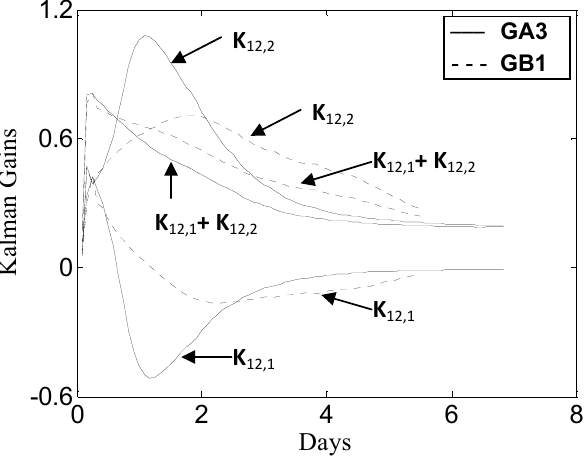
Figure 11. Evolving Kalman gain coefficients K 12 , 1 , K 12 , 2 and the sum K 12 , 1 + K 12 , 2 for GA3 and GB1 using observation depths of 1cm and the parameter initialization S6. K 12 , 1 and K 12 , 2 describe the influence of the first and second observation nodes, respectively, on node 12 (the bottom one).